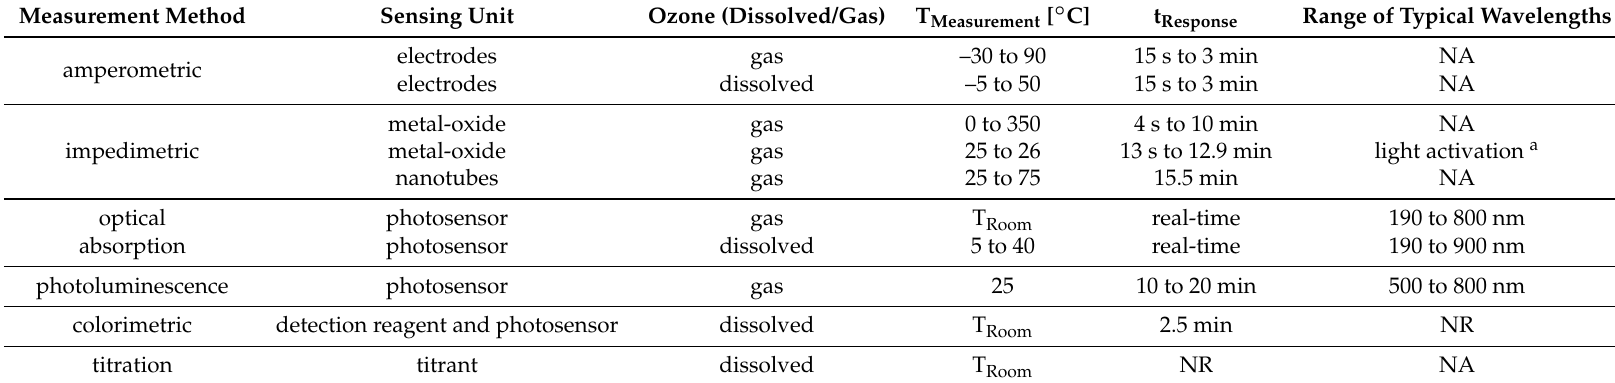
Table 1. Overview of the measurement methods for ozone sensing. Information about the ranges for several criteria, such as measurement temperature and response time, for the different measurement methods is